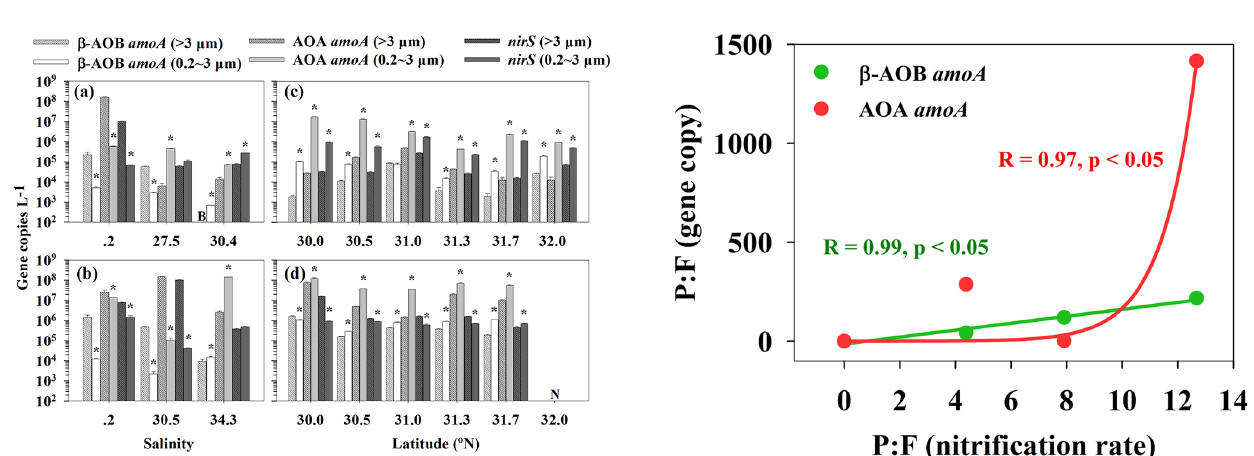
Fig. 9. Correlations between the ratios of particle-associated vs. free-living amoA gene copy numbers and the ratios of 15 N-based nitrification rates.